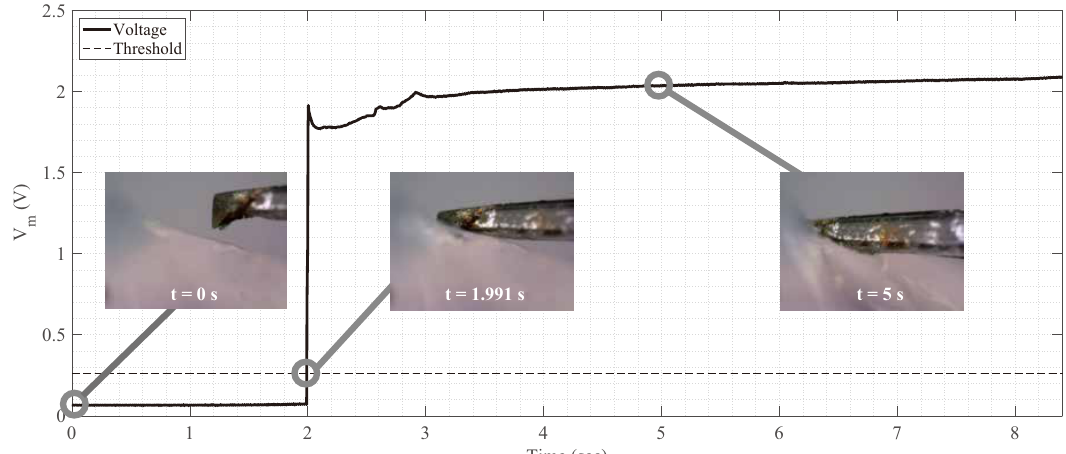
Figure 4. Sensor’s output voltage during linear insertion of the device toward the corneal tissue. Before t = 1.991 s, the voltage does not change even though the first electrode (forceps) touches the corneal tissue. At t = 1.991 s, both electrodes touch the corneal tissue, and the voltage rapidly